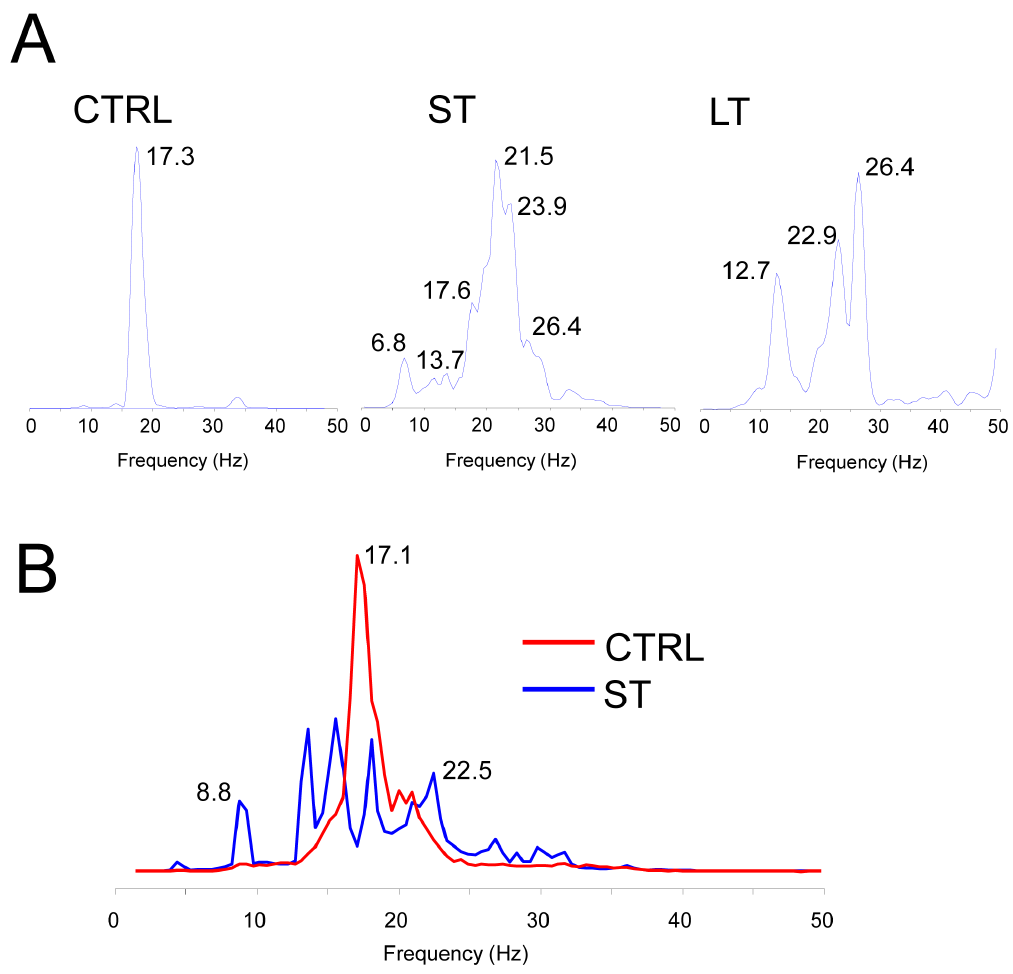
Figure 5. Welch power spectra. A. Welch averaged 10 consecutive power spectra of single animals from the CTRL (left), ST (middle) and LT (right) groups. B. Averaged power spectra of 1-second long pseudo-ECG segments for 93 VF events lasting more than 2 seconds in the CTRL (red) group and for 29 VF events lasting more than 2 seconds in the ST (blue) group (This analysis was not performed for the LT group because only 5 VF events in 4/7 animals were detected in that